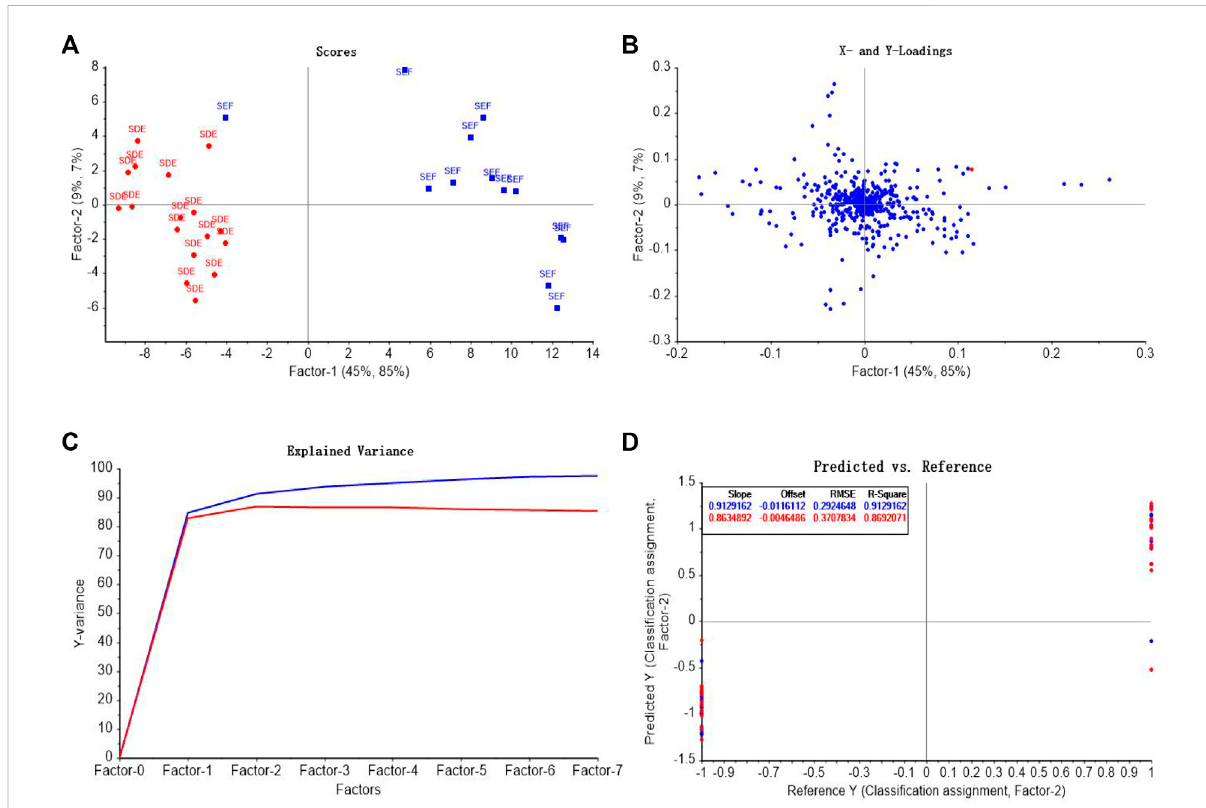
FIGURE 11 PLS-DA model analysis of different extraction methods of AEO samples. (A) PLS-DA score graph (B) The loadings of the fi rst two components for PLS-DA; (C) Explained variance of factors in PLS-DA model (D) Comparison of predicted values and reference values of AEOs by PLS-DA.